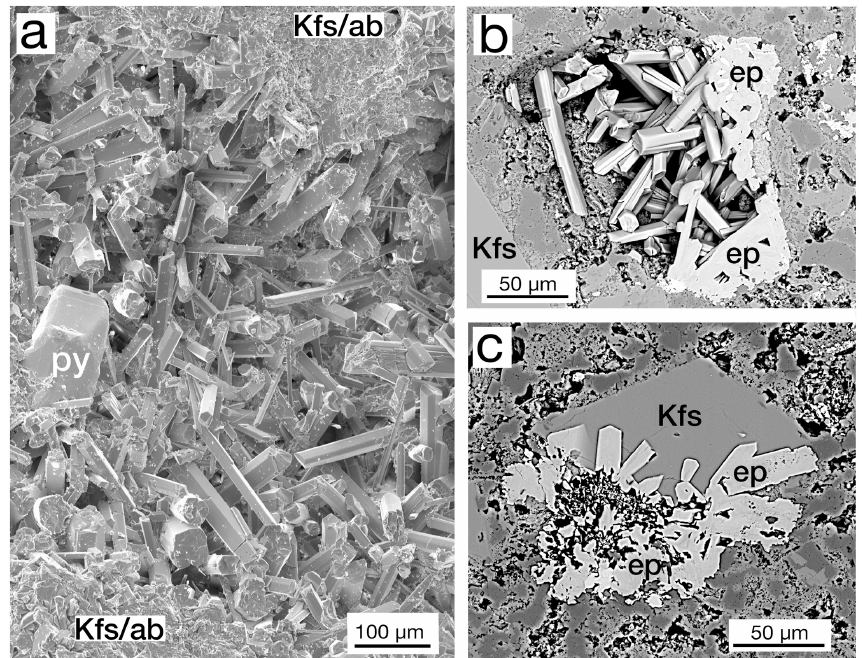
Figure 3. (a) Centimeter-size vug of epidote crystals in sample MF1-1597 in potassium feldspar and albite (Kfs/ab) with crystals of pyrite (py), SE image. (b) Vug in sample SV1-2125 containing crystals of epidote (ep) surrounded by K-feldspar (Kfs), backscattered electron (BSE) image. (c) Vug filled with epidote (ep) crystals subsequently filled by K-feldspar (Kfs), sample MF1-1495, BSE